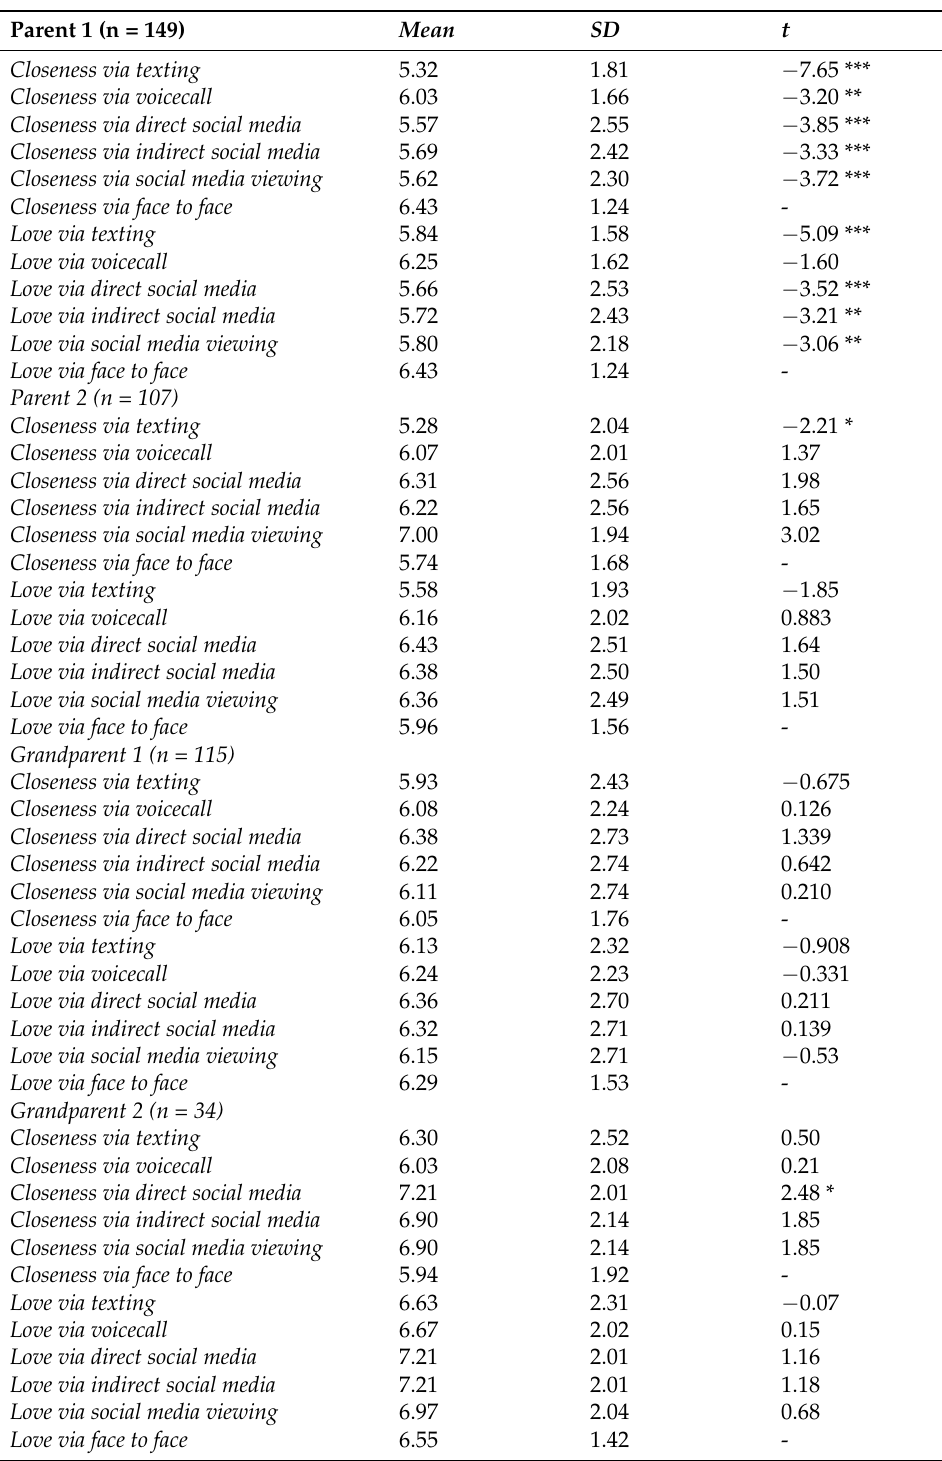
Table 2. Paired samples T-tests ( N =